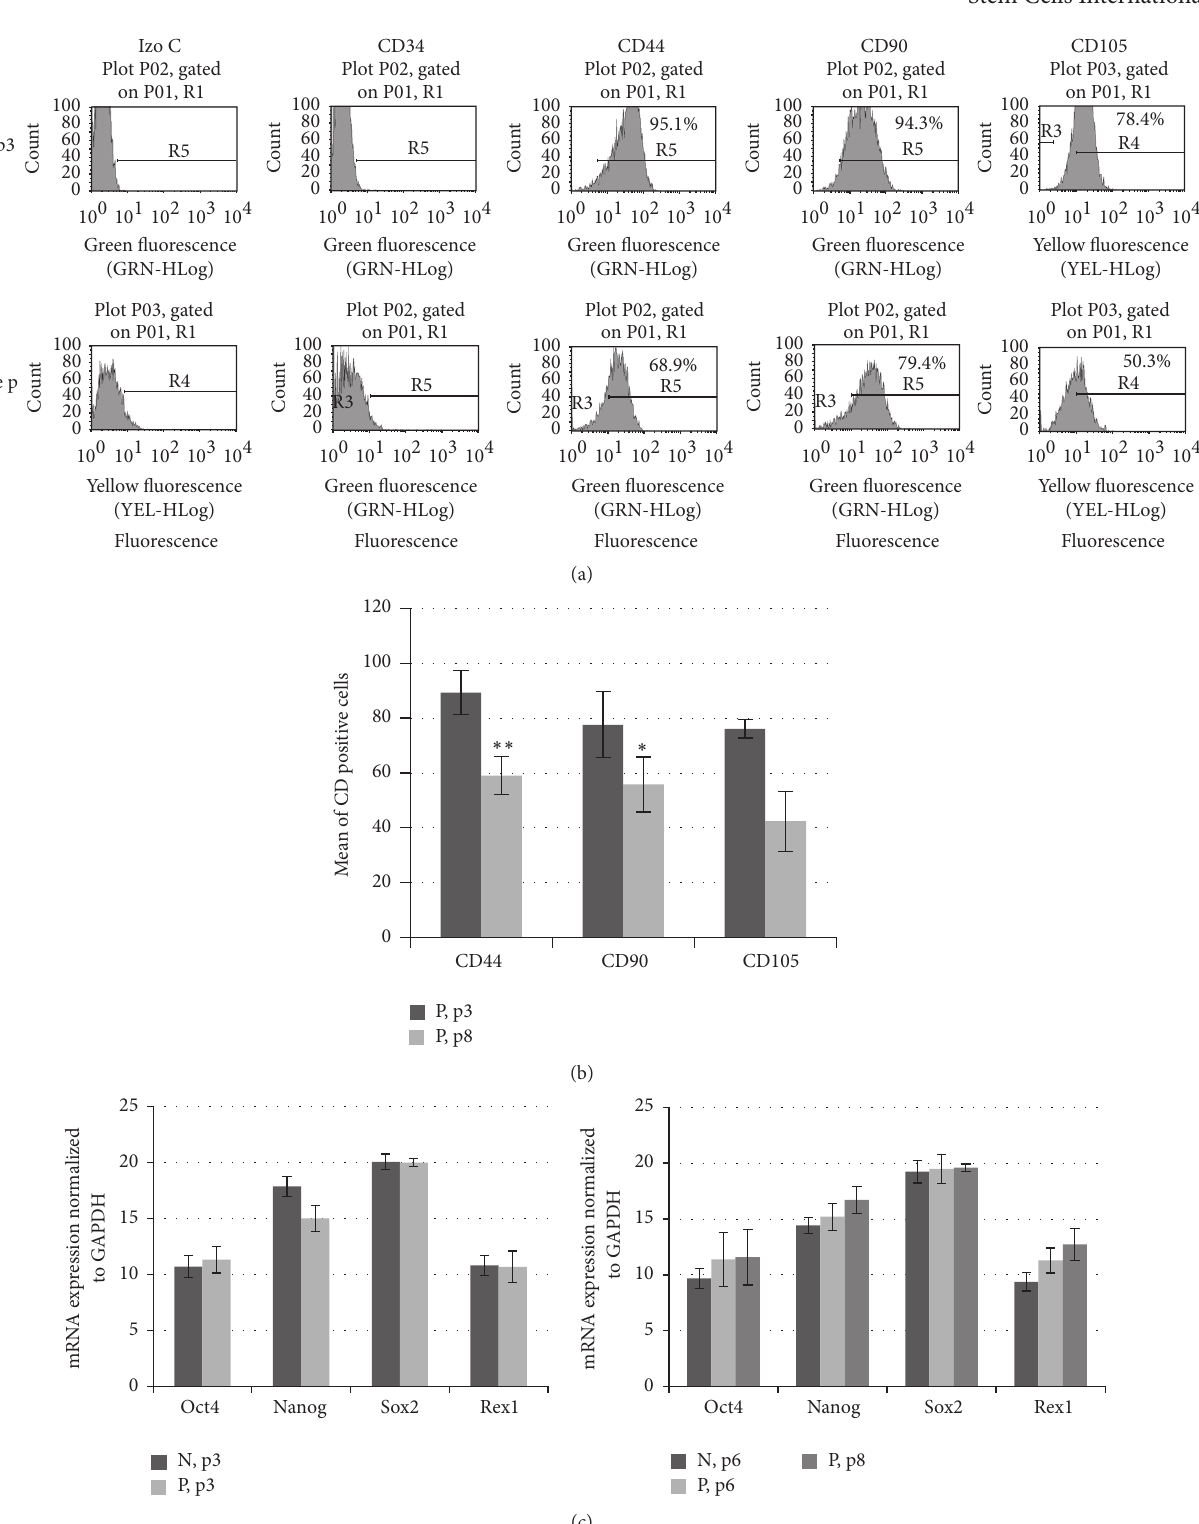
Figure 2: Immunophenotype and stemness markers of MSCs derived from AF of normal and pathological gestation during cultivation. (a) Representative flow cytometry histograms of cell surface antigen markers of MSCs obtained from AF of normal gestation (N) at passage 3 and the late passage 8. Cells were positive for staining with CD44, CD90, and CD105 antibodies and negative for CD34 antibody.